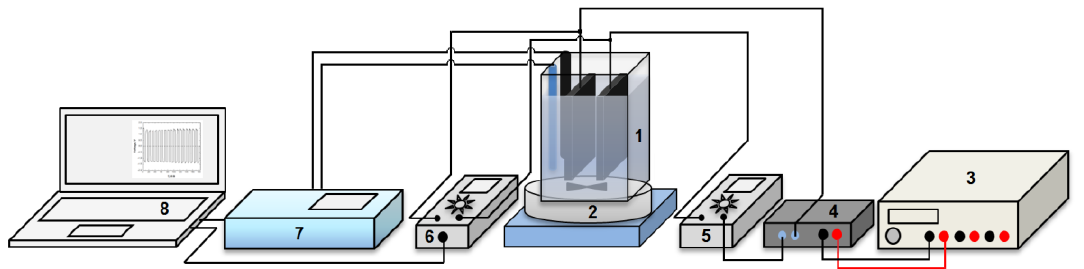
Figure 1. Experimental set-up operated in Alternative Pulsed Current (APC) mode. [1—electrocoagulation (EC) cell; 2—magnetic stirrer; 3—Direct Current (DC) power supply; 4—polarity changer; 5—ammeter; 6—data logging voltmeter; 7—multi-parameter